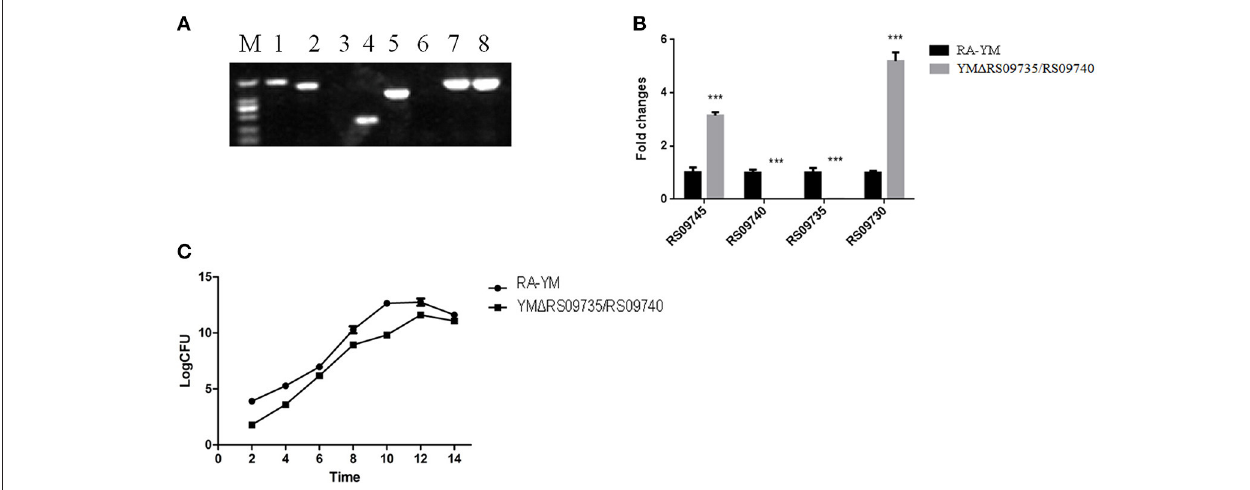
FIGURE 2 | Characteristics of YM 1 RS09735/RS09740 strain. (A) PCR amplification. M, DL2000; Lane 1, RAYM_RS09735/RAYM_RS09740 was amplified from YM 1 RS09735/RS09740 strain; Lane 2, RAYM_RS09735/RAYM_RS09740 was amplified from RA-YM strain; Lane 3, delta genes were amplified